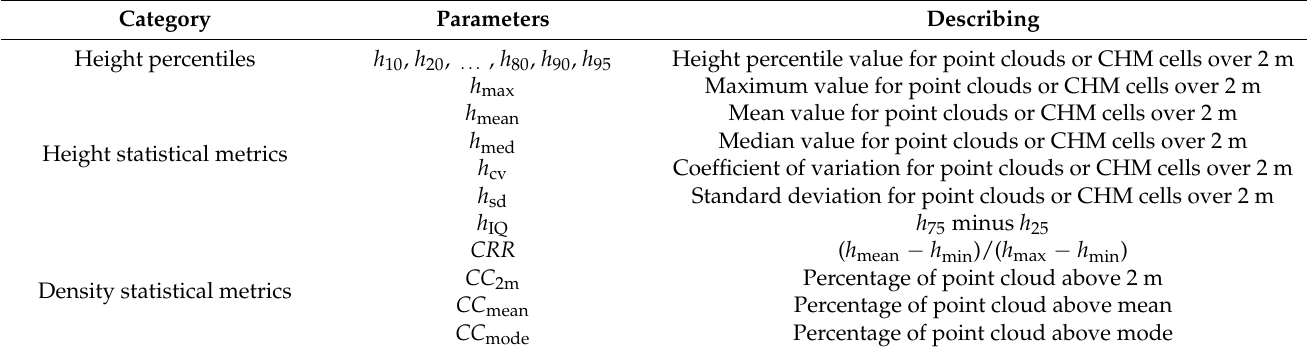
Table 3. The metrics extracted from normalized point clouds or CHMs.